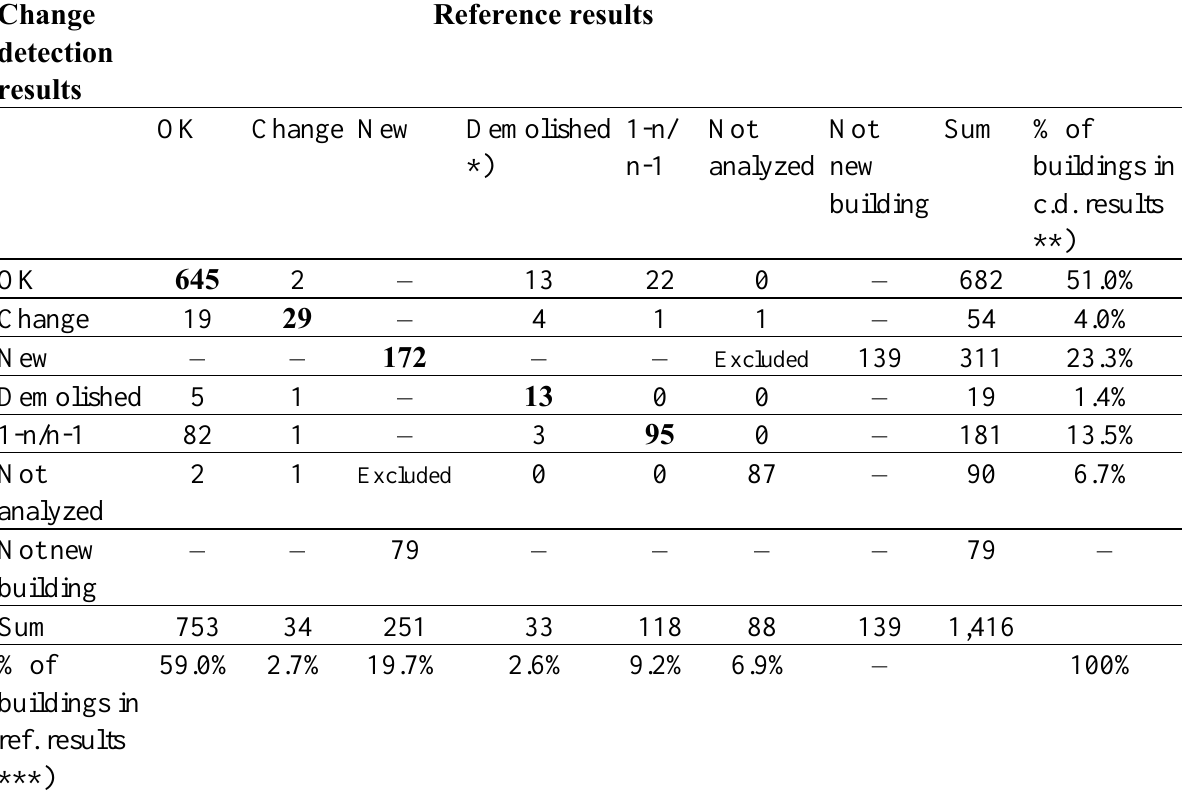
Table 4. Confusion matrix for the change detection results (overlap approach used). All test areas and buildings included (threshold value  20 m 2 ), class 5